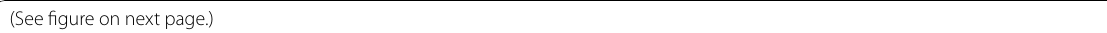
SD, n 6 mice/group. *P < 0.05 and ± =